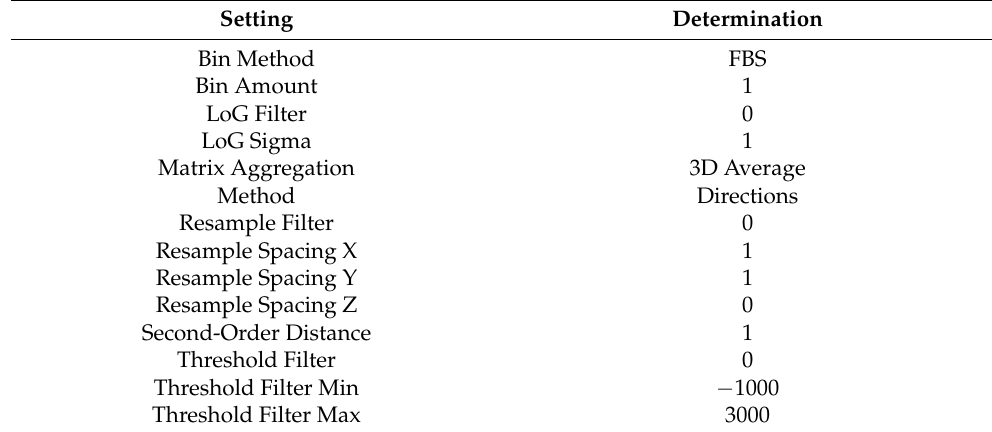
Table A1. Settings of the feature extraction.